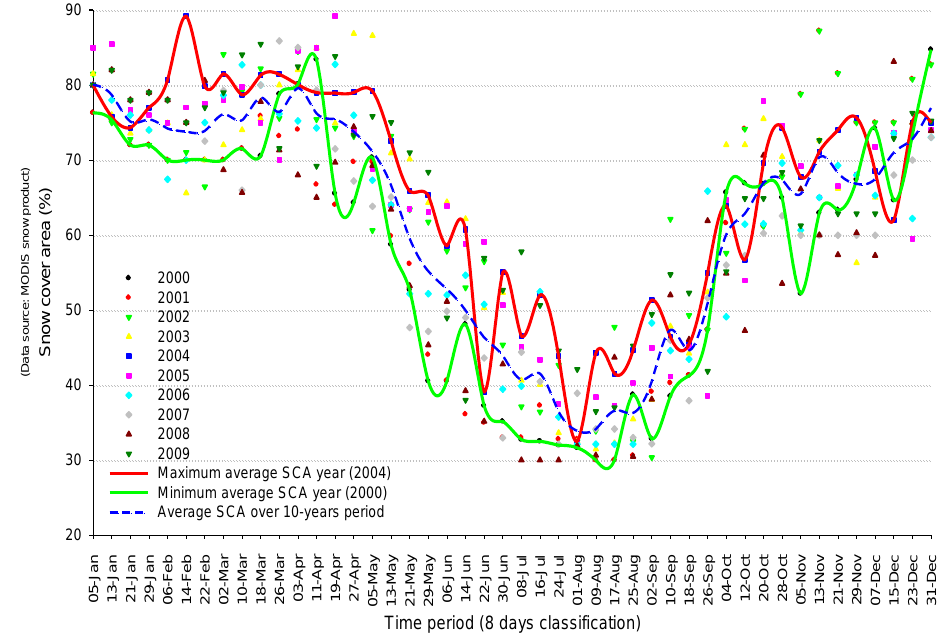
Fig. 6 Percentage snow cover area (SCA) in the Hunza River basin calculated by analysing 450 MODIS images.